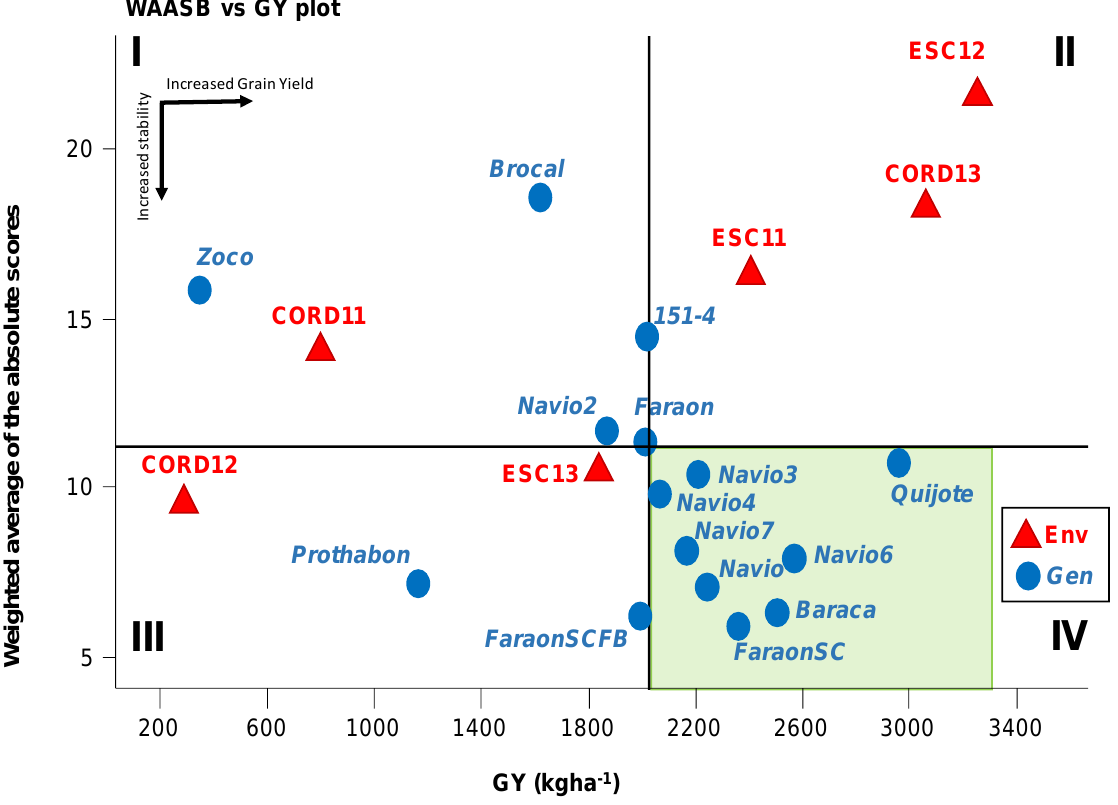
Figure 1. Biplot of grain yield vs. weighted average of absolute scores for the best linear unbiased predictions of the GEI (WAASB) of 15 faba bean genotypes tested in six environments. Horizontal understand black arrows indicate the direction of the increase in grain yield; vertical arrows indicate increase of stability.